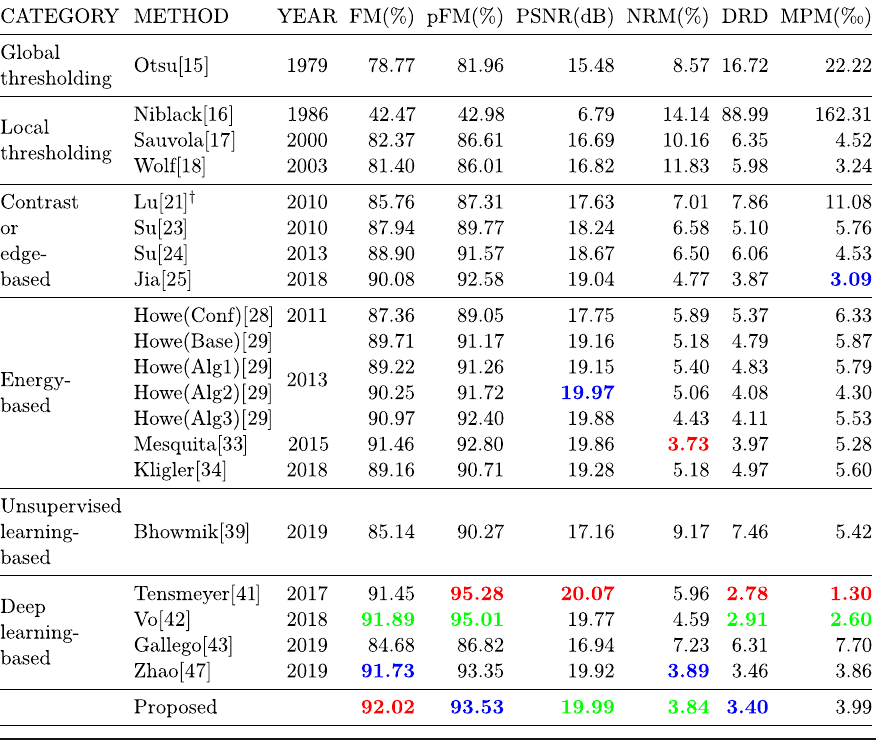
Table 2 Performance evaluation results of our proposed method against the state-of-the-art techniques on the nine DIBCO and H-DIBCO testing datasets (the first, second, and third best results in bold red, green, and blue font,